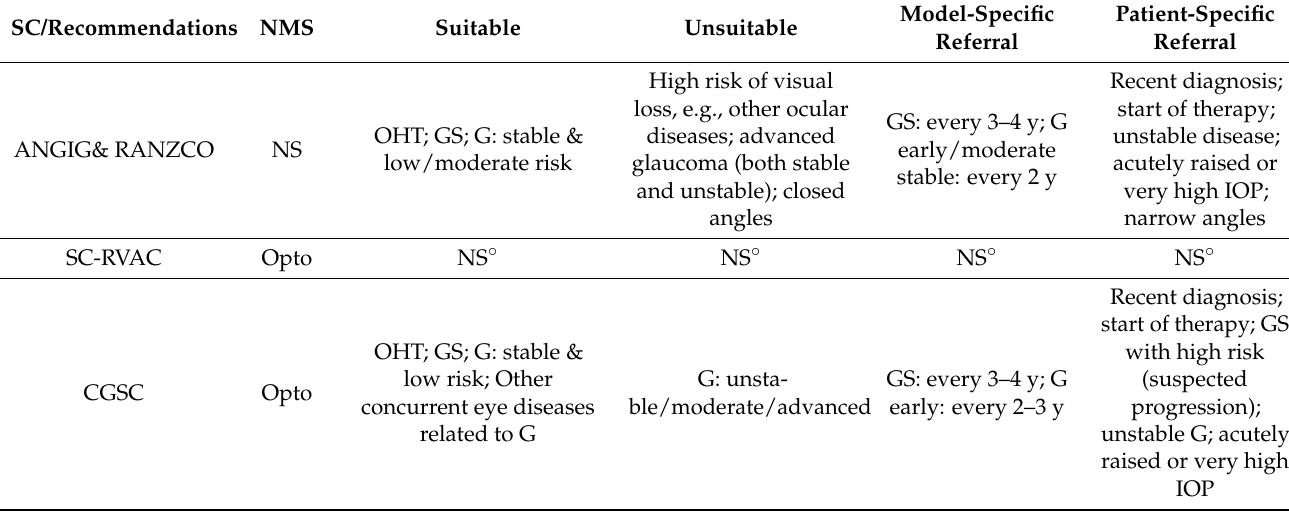
Table 3. The characteristics that render patients suitable or unsuitable for each shared care clinic, along with a list of conditions requiring referral to a Glaucoma